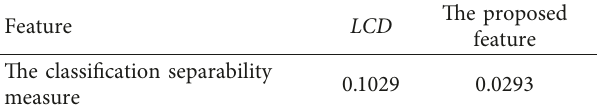
Table 2: Sort separability criterion of different features.